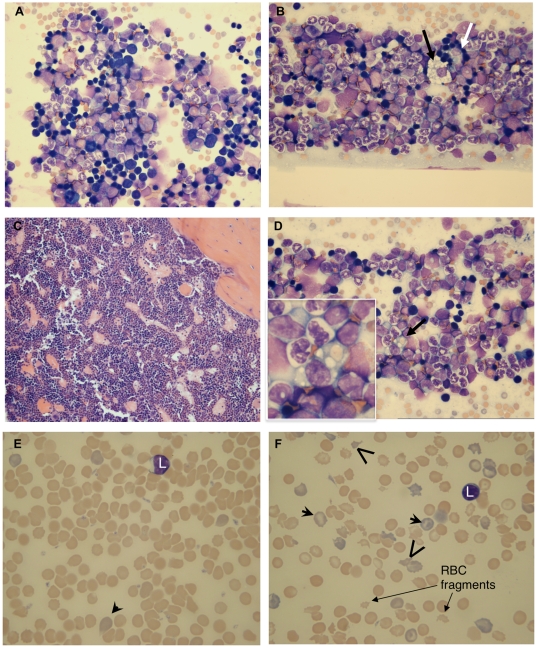

S. Typhimurium-infected mice have increased hemophagocytic macrophages, myeloid hyperplasia, regenerative microcytic anemia and erythrocyte fragmentation.(A) Control bone marrow cytology, 3 weeks post mock-infection. (B) Infected mouse bone marrow cytology, 3 weeks post-infection; myeloid hyperplasia with increased blasts and monocytes, hemophagocytic macrophage (white arrow), and foamy macrophage (black arrow). (C) Bone marrow histology, 6 weeks post-infection; hypercellularity with myeloid hyperplasia. (D) Mouse bone marrow cytology, 3 weeks post-infection; erythrocyte (arrow and inset) within hemophagocytic macrophage. (E) Control mouse blood film, 3 weeks post mock-infection. (F) Blood film from highly infected mouse, 3 weeks post-infection; marked erythrocyte anisocytosis, increased polychromasia and markedly fragmented erythrocytes (mature and polychromatophilic). Polychromatophilic erythrocytes (arrow-heads), fragmented polychromatophilic erythrocytes (carats), fragmented erythrocytes (arrows), L = small lymphocyte. Wright stain (A, B, D, E, F). H & E stain (C). Original magnifications 500× (A–B, D), 200× (C), or 1000× (E–F).